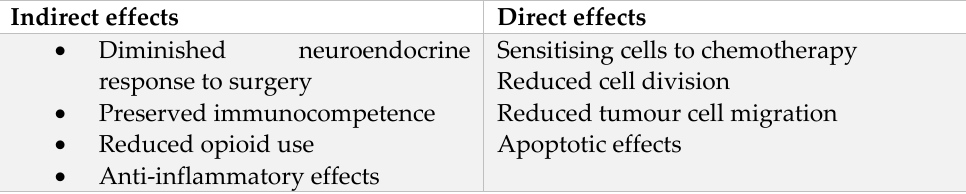
Figure 4. Summary of the actions of lidocaine on cancer cell activity, adapted from [79]. Despite the many studies, limitations are present which preclude definitive conclusions to be drawn regarding the effect of lidocaine in reducing cancer metastasis and recurrence. The plethora of evidence and studies demonstrate a multitude of potential mechanisms by which lidocaine may act as an immune-modulating drug. However, each cancer has different cell types which are unique in their function; thus, no clear consensus can be made regarding the exact mechanism by which lidocaine may demonstrate a therapeutic effect. Further research is needed in order to fully translate laboratory findings into clinical implications. 7. Clinical Recommendations and Safety With regards to lidocaine being used intravenously in the perioperative setting, there are multiple reasons it may be used. One such reason is its use in reducing pain from the propofol injection. Propofol-induced injection pain is a common occurrence during the induction of anaesthesia with propofol. Whilst the underlying mechanism for this pain is unclear, it is likely due to a combination of nociceptor stimuli and release of pain mediators such as bradykinin. Studies have shown that lidocaine given prior to propofol injection, either mixed with propofol or given separately, with or without venous occlusion, reduced post-injection pain. Its exact mechanism in reducing pain remains unclear [80].